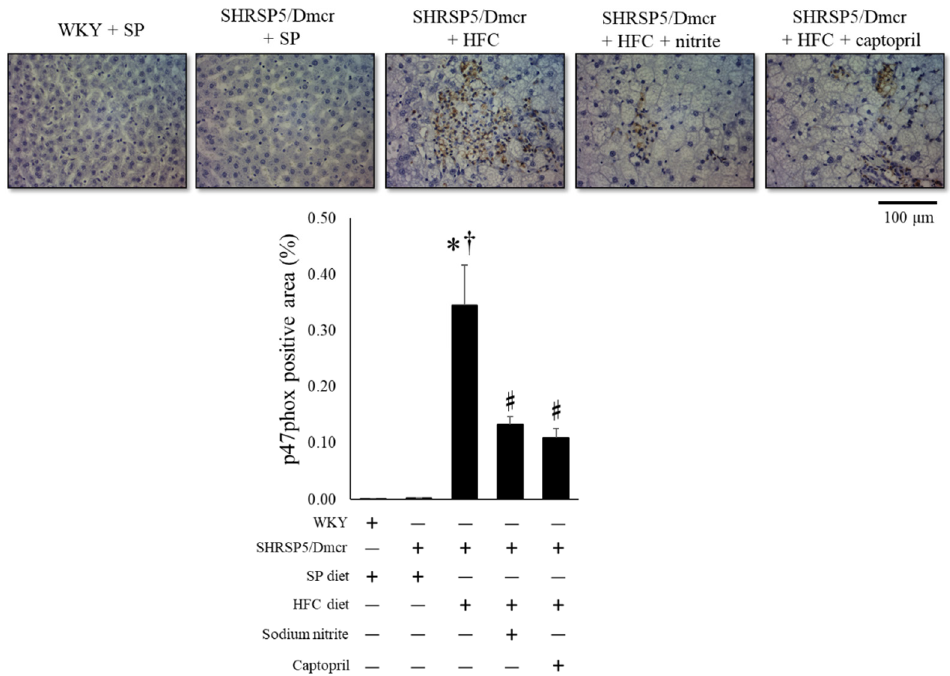
Figure 4. Immunohistochemical analysis of p47phox-positive area in the hepatic tissues of the rat nonalcoholic steatohepatitis model treated with nitrite and captopril. Results are expressed as mean ± SE ( n = 6), Values represent mean ± SE ( n = 6), * p < 0.05 vs. WKY + SP diet group, † p < 0.05 vs. SHRSP5/Dmcr + SP diet group, ♯ p < 0.05 vs. SHRSP5/Dmcr + HFC diet group.